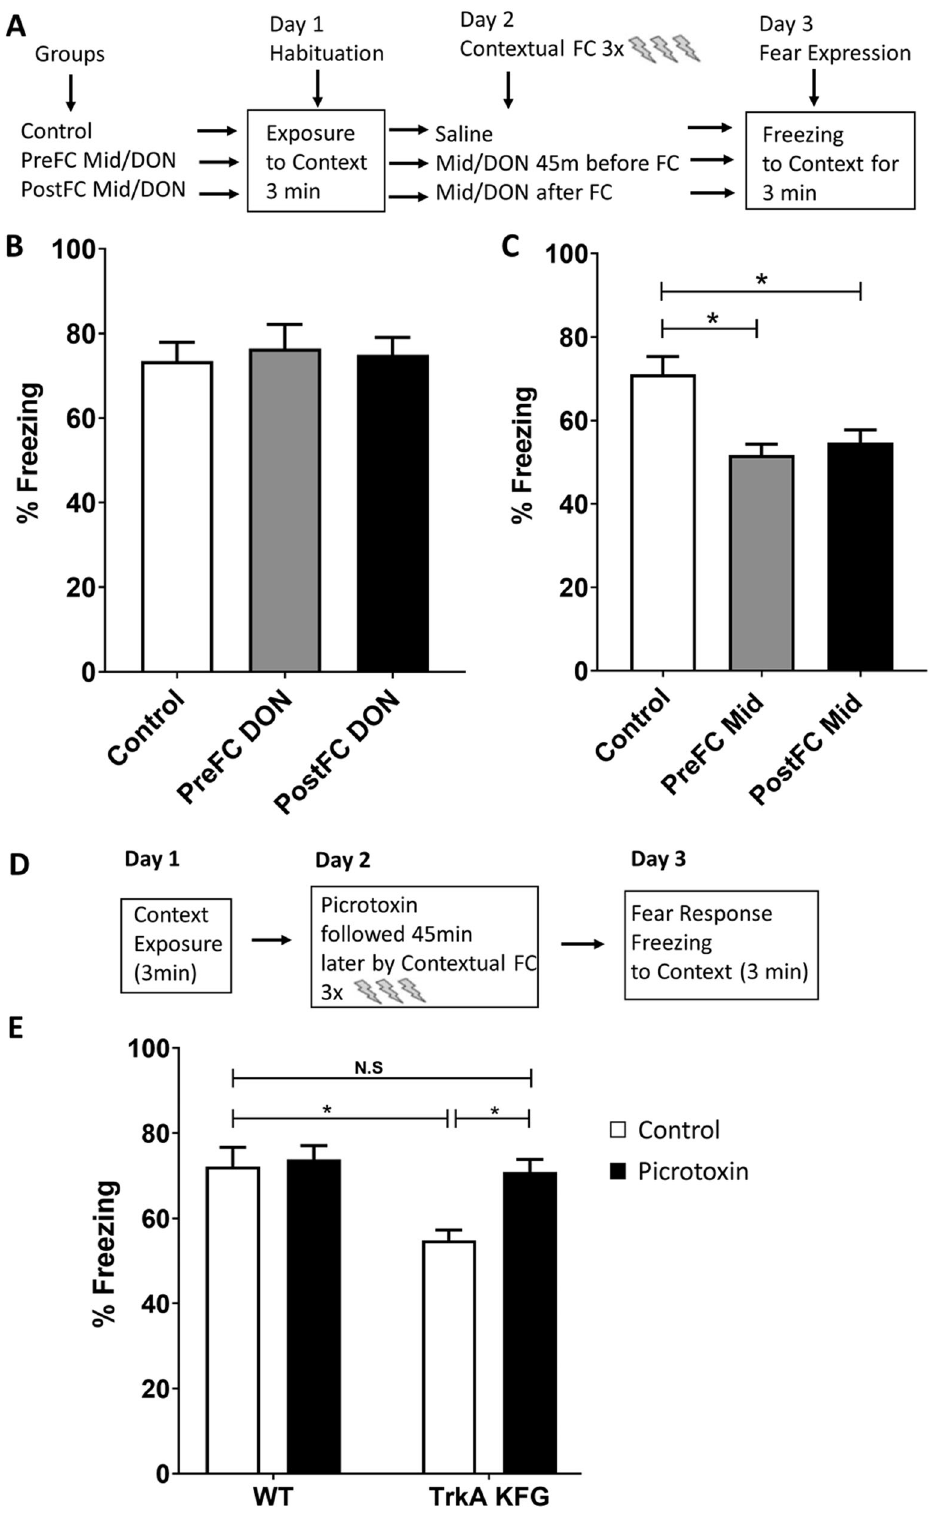
Fig. 4 GABAergic signaling regulates acute contextual fear response. A , D Schematic representation of the protocols used to test GABAergic and cholinergic signaling role in contextual fear response. B , C Quanti fi cation of the freezing response of WT mice treated with donepezil (DON, B ) or midazolam (Mid, C ) 45min before (PreFC DON or PreFC Mid) or immediately after (PostFC DON or PostFC Mid) contextual fear conditioning showing that augmentation of GABAergic signaling with midazolam reduces fear response when injected either before or immediately after contextual fear conditioning. * p <0.05, non-parametric ANOVA followed by Dunn ’ s multiple comparison test, n = 8/group). E The GABA antagonist picrotoxin injected (0.5mg/kg intraperitoneal) 45min before fear conditioning restores the fear response of TrkA-KFG mice to WT control levels. N = 8 – 10/group. Note that picrotoxin, per se, does not alter the fear response in WT animals. * p <0.05, Two-way ANOVA followed by Tukey Multiple comparison